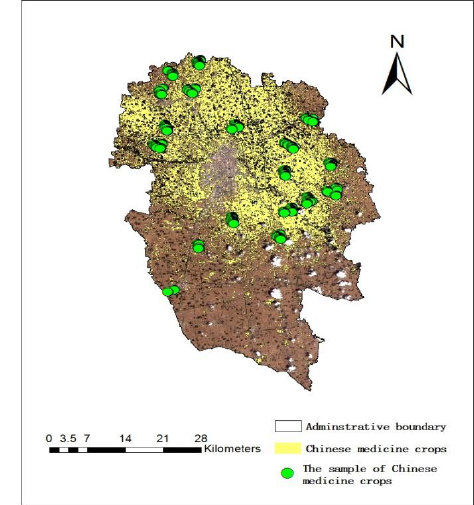
Figure 9. Spatial distribution of samples of Chinese medicine crops in Qiaocheng District.